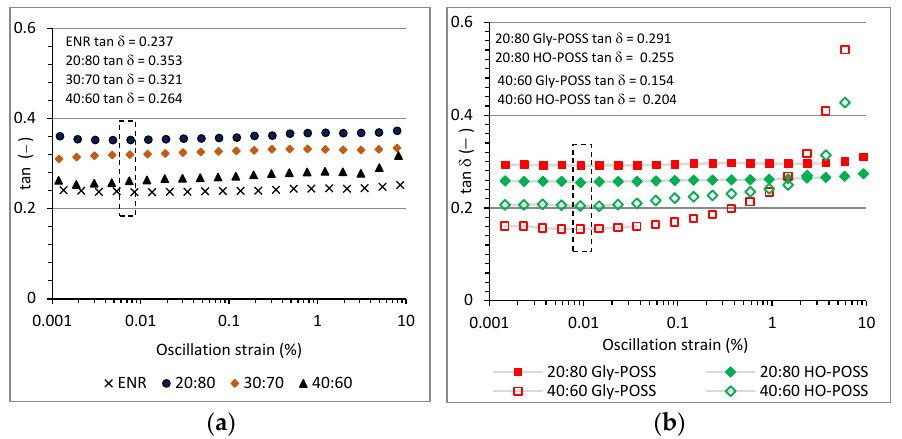
Figure 8. Damping properties, the loss tan δ as a function of oscillation strain at 30 °C and angular frequency of 20 Hz for various PLA/ENR ( a ) and PLA/ENR/POSS formulations ( b ).